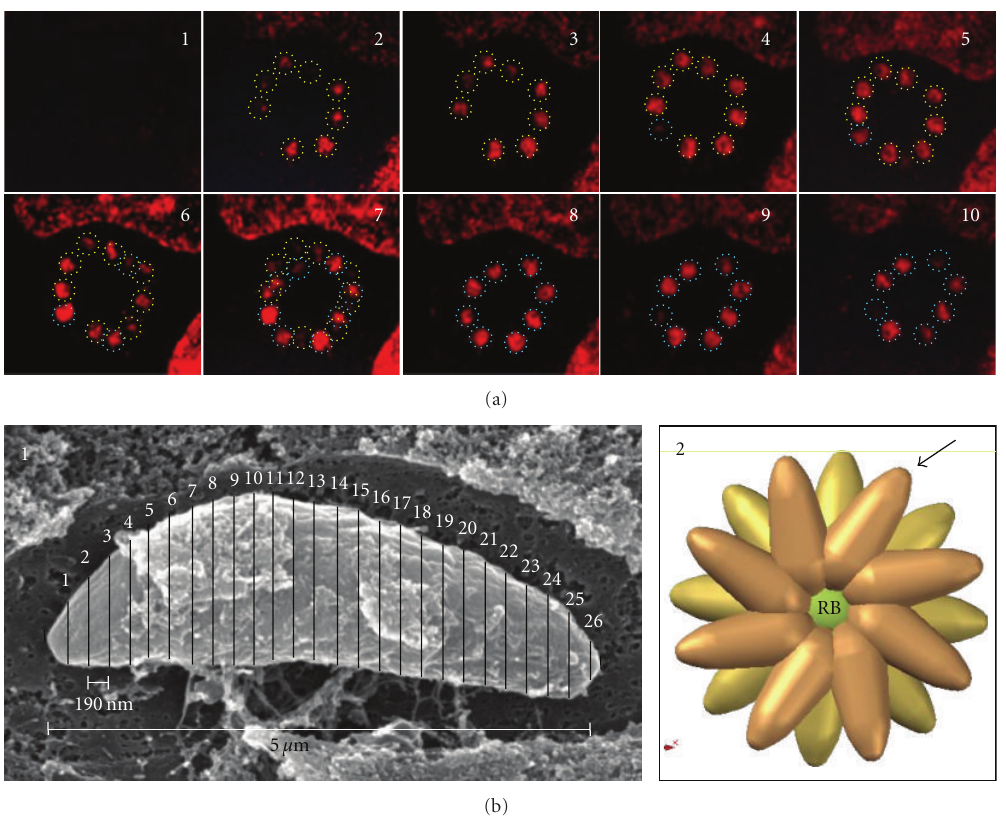
Figure 5: Proliferating tachyzoites arranged in rosettes are localized in two planes within the PV. (a) Confocal serial sections of proliferating tachyzoites arranged in rosette and stained with DAPI to show nuclear distribution. Confocal images 3 and 8 show the spatial arrangement of tachyzoites in two planes each containing 8 parasites. The interaction between both planes is showed in confocal image 7. (b) SEM-Tanaka micrograph of tachyzoite after 1h of invasion that was used as a template to build the 3D digital model of the rosette; it was sectioned in 26 portions of 190 nm each and was used to build a digital model that was in turn used to design a 3D digital model of a rosette (C). Arrow, apical extreme of parasite, RB: residual body. Bar = 5 µ